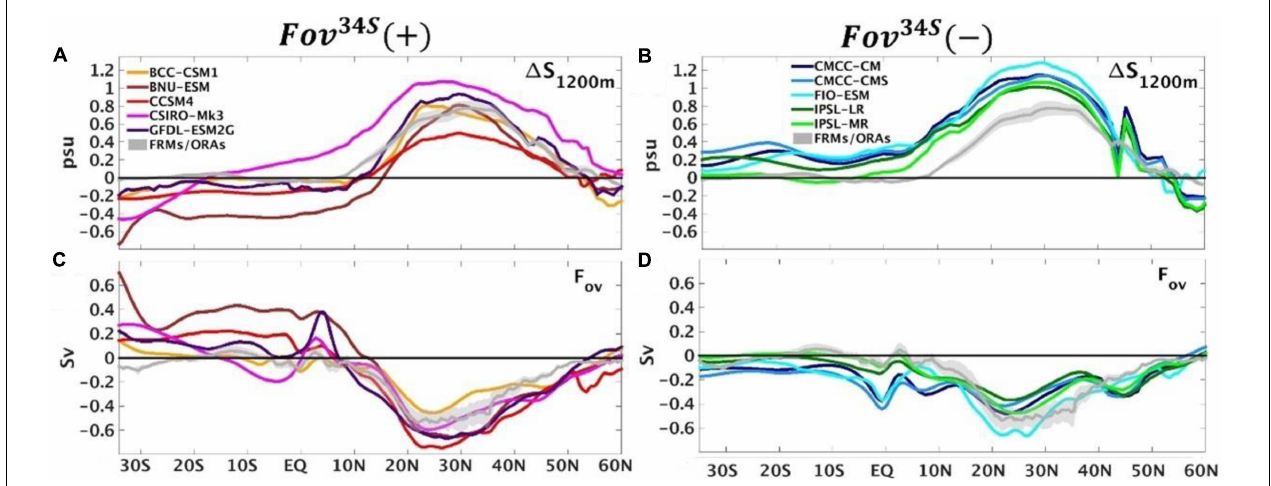
FIGURE 2 | The mean (A,B) (cid:49) S 1200m (psu), and (C,D) F ov (Sv), divided into two CMIP5 groups of positive (left) and negative (right) F ov 34 S , respectively.